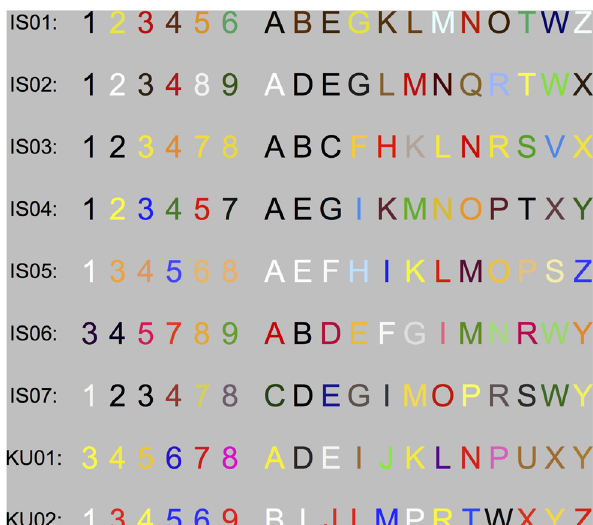
Fig 2. The experimental stimulus sets of each synesthete. Digits were used as distractors and letters as targets in experiment 1. Grapheme colors are averages (in RGB color space) over three trials of grapheme- color mapping on a computerized color palette (see Fig